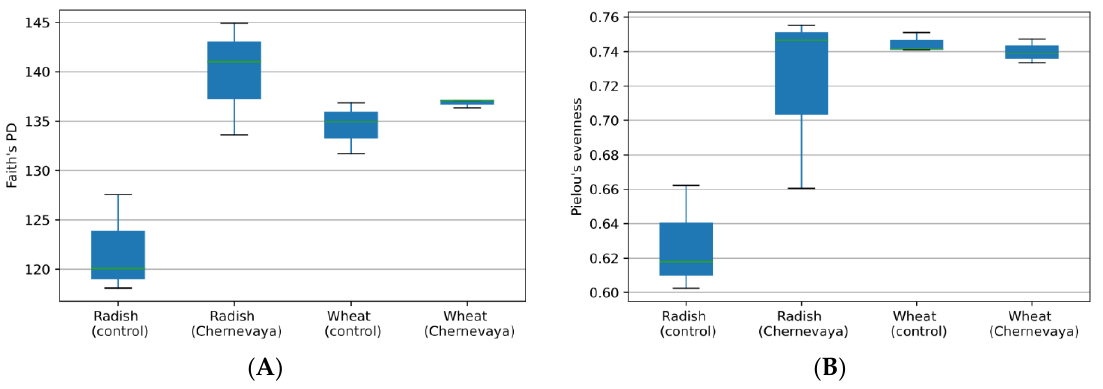
Figure 2. Diversity of the microbial communities in the rhizosphere of radish and wheat plants growing at the Chernevaya and control soils based on Faith’s phylogenetic diversity index ( A ) and Pielou evenness index ( B ).